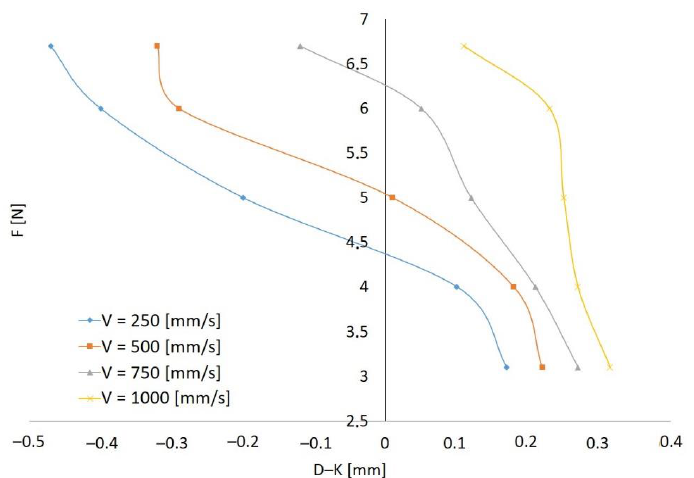
Figure 10. Graph of correctness of machining as a function of force for different values of the speed of the TCP.